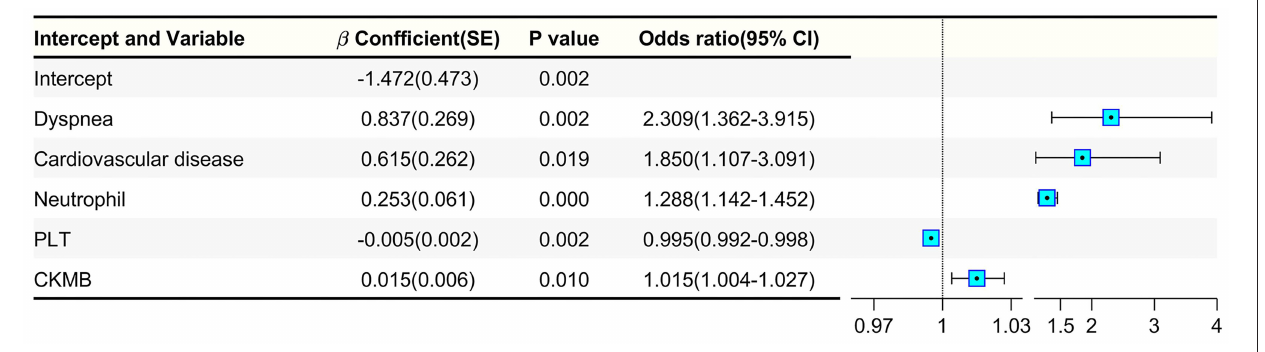
FIGURE 2 | Binary logistic regression analysis of severity-related factors in diabetic patients with